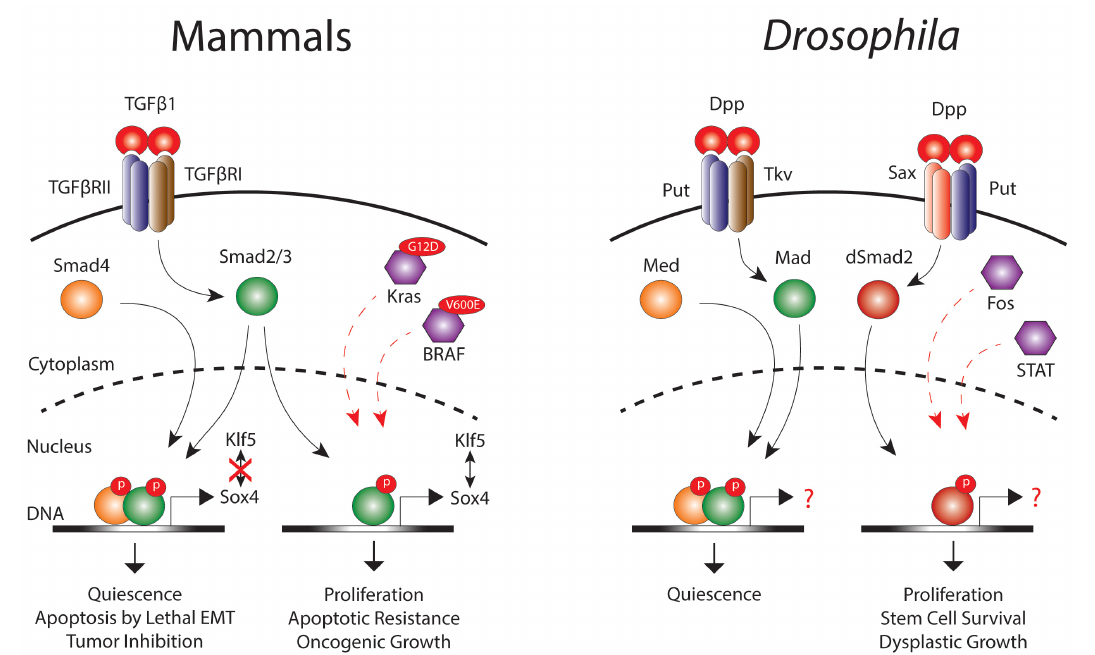
Figure 2. Transforming growth factor β ( TGF β ) signaling during homeostasis and cancer. In mammals, TGF β 1 activates TGF β receptors to recruit the canonical Smad2/3–Smad4 complex that, upon nuclear translocation, promotes quiescence and induces lethal epithelial- mesenchymal transition (EMT) to limit tumor growth. Loss of Smad4 in Kras G12D -mutant cells as well as acquisition of a BRAF V600E mutation divert the activity of phosphorylated Smad2/3 to promote cell proliferation, survival, and metastatic growth. Similarly, Drosophila Decapentaplegic (Dpp) stimulates Punt (Put) and Thickveins (Tkv) receptors to activate the canonical Mad-Med (Smad4 homologue) nuclear complex that promotes quiescence. Overactivation of epidermal growth factor receptor (EGFR)/Fos and Jak/signal transducer and activator of transcription (STAT) signaling re-directs Dpp to activate the alternate Put–Saxophone (Sax) receptor complex. This complex then activates dSmad2, which translocates into the nucleus independently of Med and induces tumor-like stem cell growth and